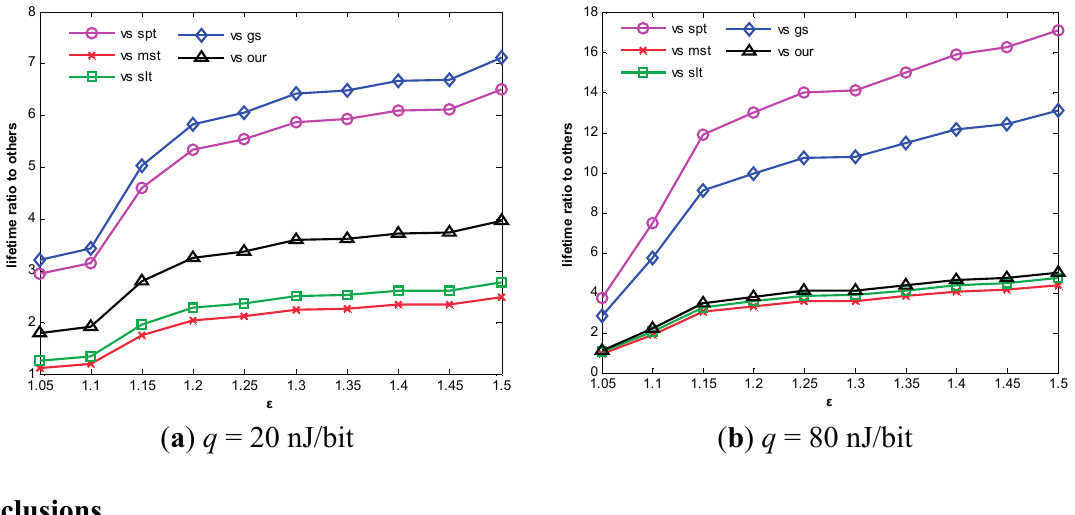
Figure 10. Lifetime ratio of our algorithm to other